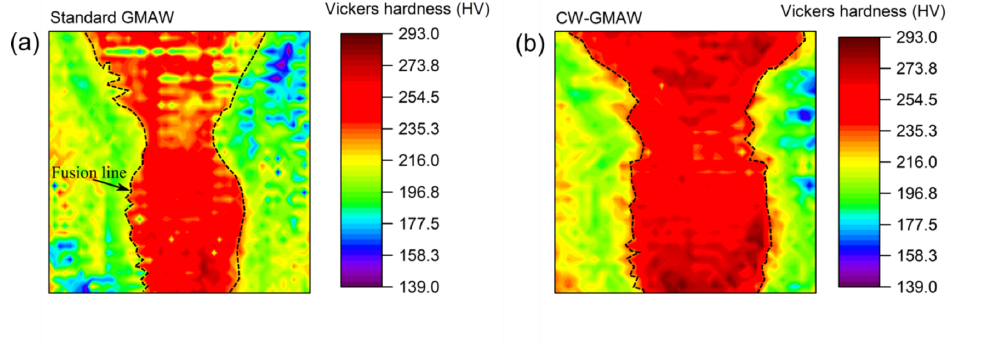
Figure 12. Hardness map of the cross-sections: ( a ) standard GMAW; and ( b ) CW-GMAW, with weld interface marked by dashed lines.